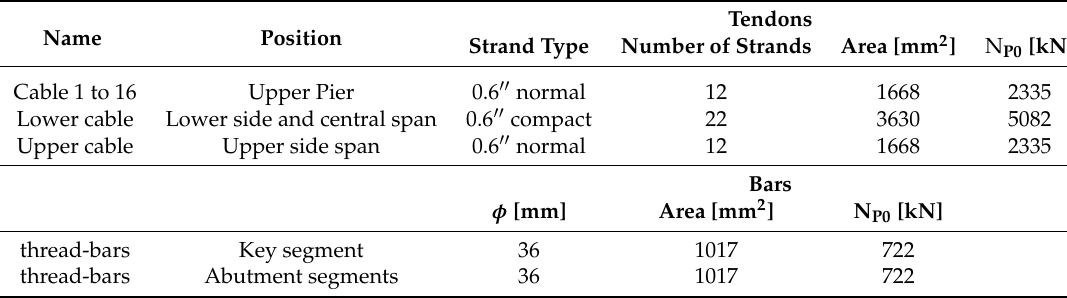
Table 2. Details of the post-tension tendons and bars.